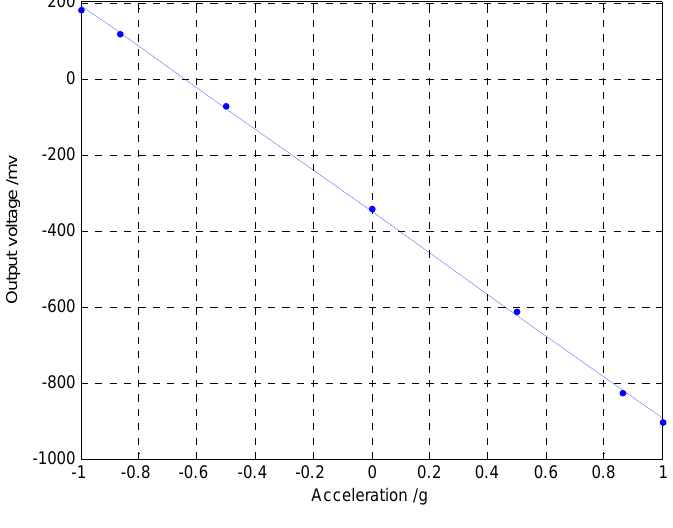
Figure 13. Output fitting curve of vacuum microelectronic